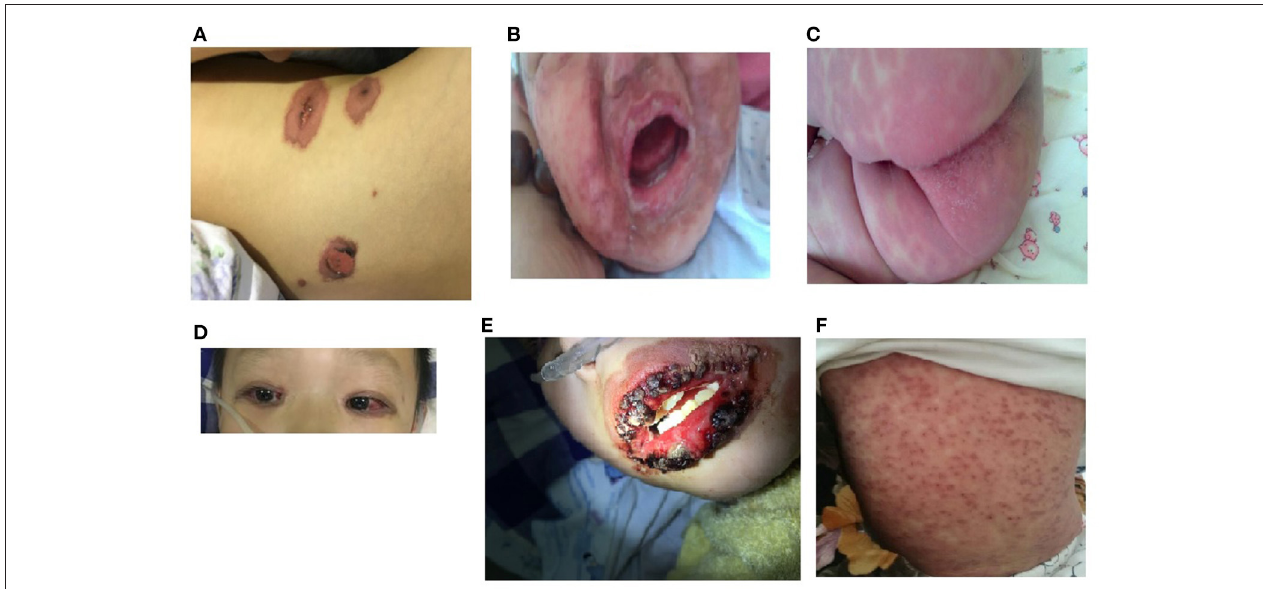
FIGURE 1 | Morphological characteristics of rash of younger and older MIRM children. (A) An older child with a sparse red maculopapular rash, with some vesicular lesions. (B,C) Relatively mild mucositis in children aged < 2 years, with the dense erythema without blistering, less purulent exudation, and no hemorrhagic lesions. (D) Conjunctival hyperemia of an older child’s eyes. (E) Hemorrhagic crusting eruption on the lip of an older child. (F) Targetoid lesions and purpuric macules of the skin of a child aged < 2 years